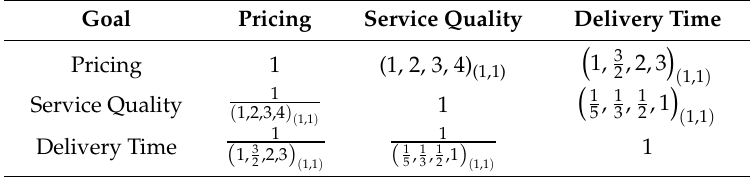
< a 3 and m = n = 1. ij ij